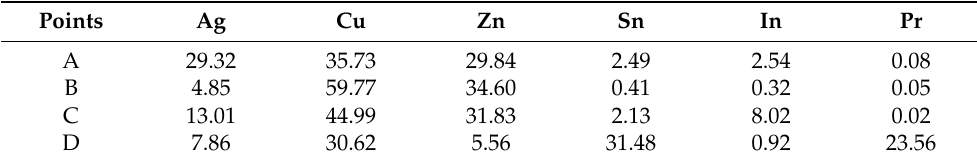
Table 3. EDS analysis of the points indicated in Figure 5 (at.%).